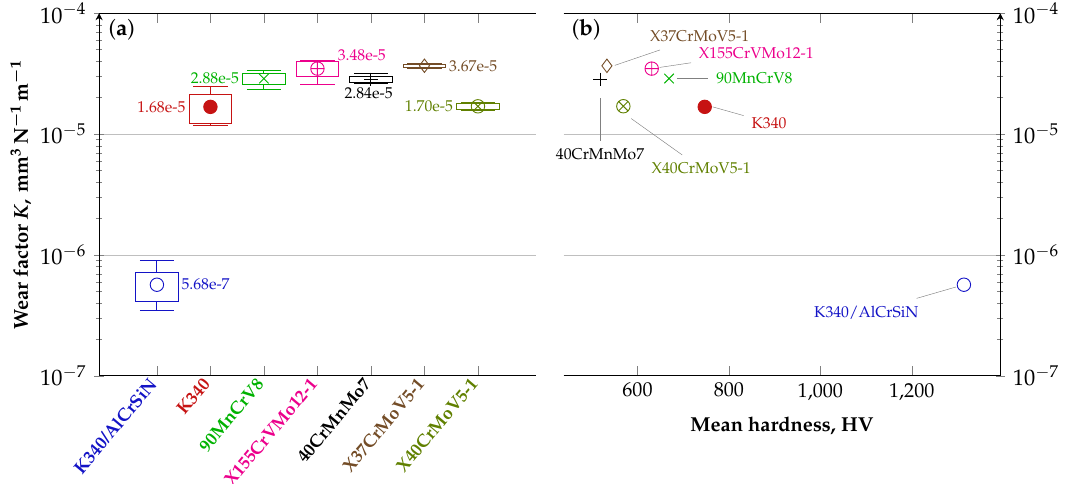
Figure 4. Curves illustrating variations in friction coefficient vs. distance for the tested materials.